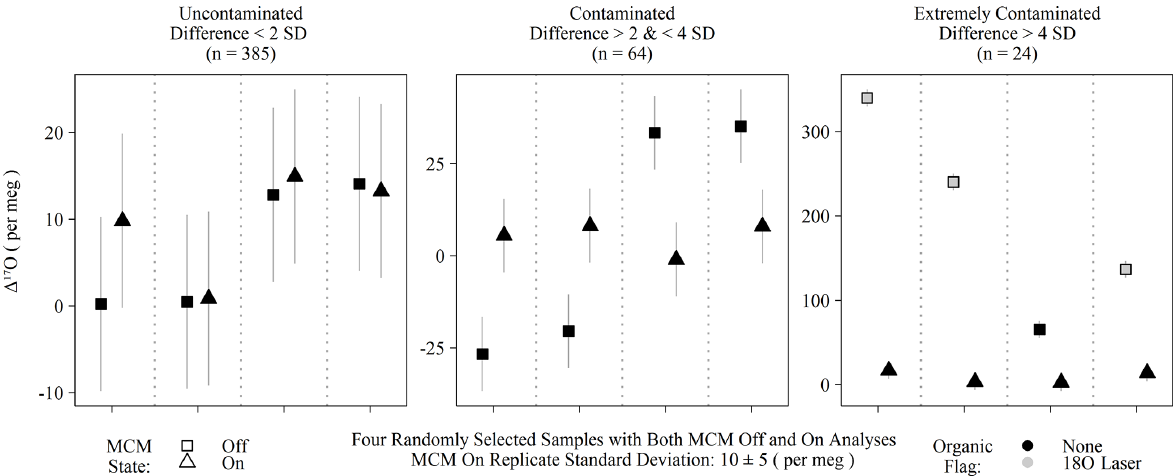
Figure 4. Randomly selected subset of calibrated (cid:49) 17 O of samples run with the MCM off and on categorized into three groups based on the differences between the MCM off and on analyses. Differences exceeding 2 standard deviations of instrumental precision are assumed to derive from organic contamination. Only “extremely contaminated” samples are typically identified by spectral flags as having organic interference (grey-filled